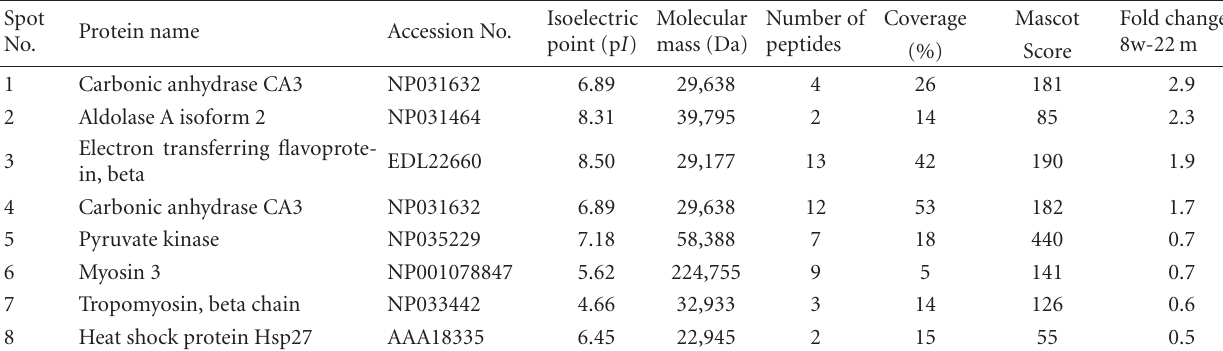
Table 2: List of identified proteins that exhibit a drastic change in abundance during aging of the dystrophic mdx tibialis anterior muscle. Spot